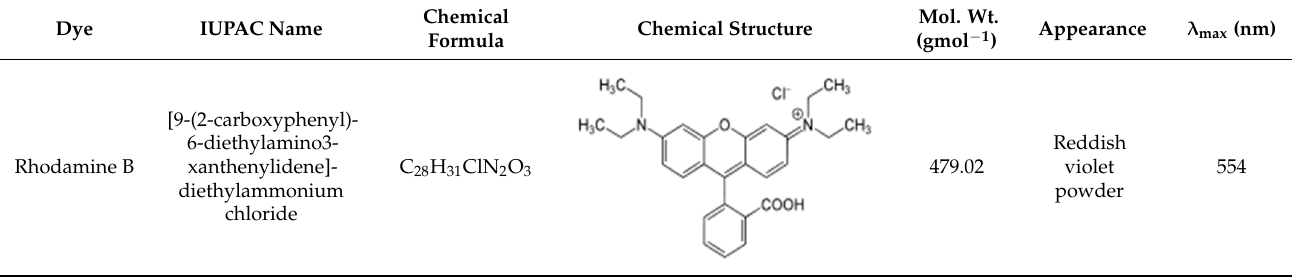
Table 1. Physical and chemical characteristics of rhodamine B (RhB) dye.